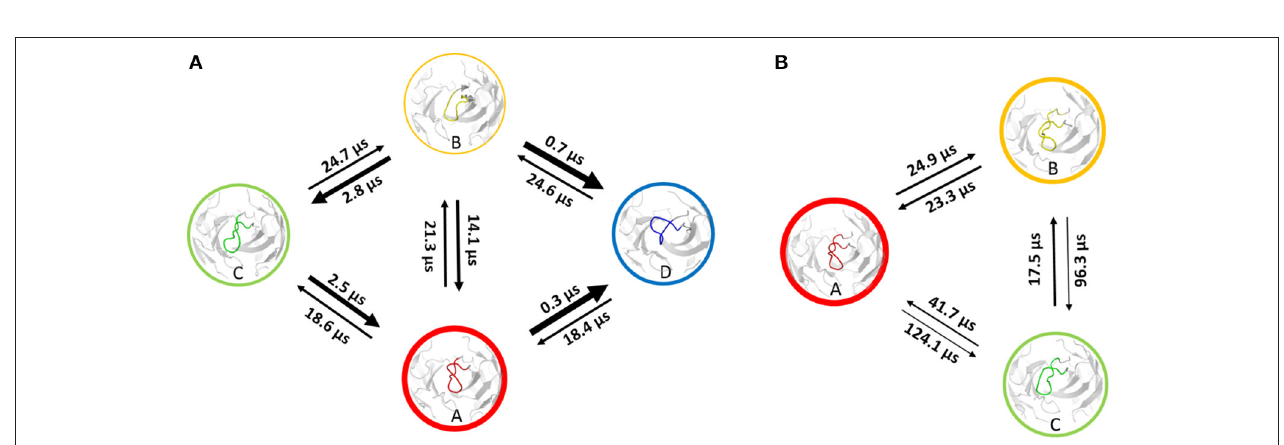
FIGURE 4 | Markov-state model of the 6C8 antibody (A) and the further matured 8B10 antibody (B) . The thickness of the circles represents the state probabilities, while the width of the arrows corresponds to the transition timescales.